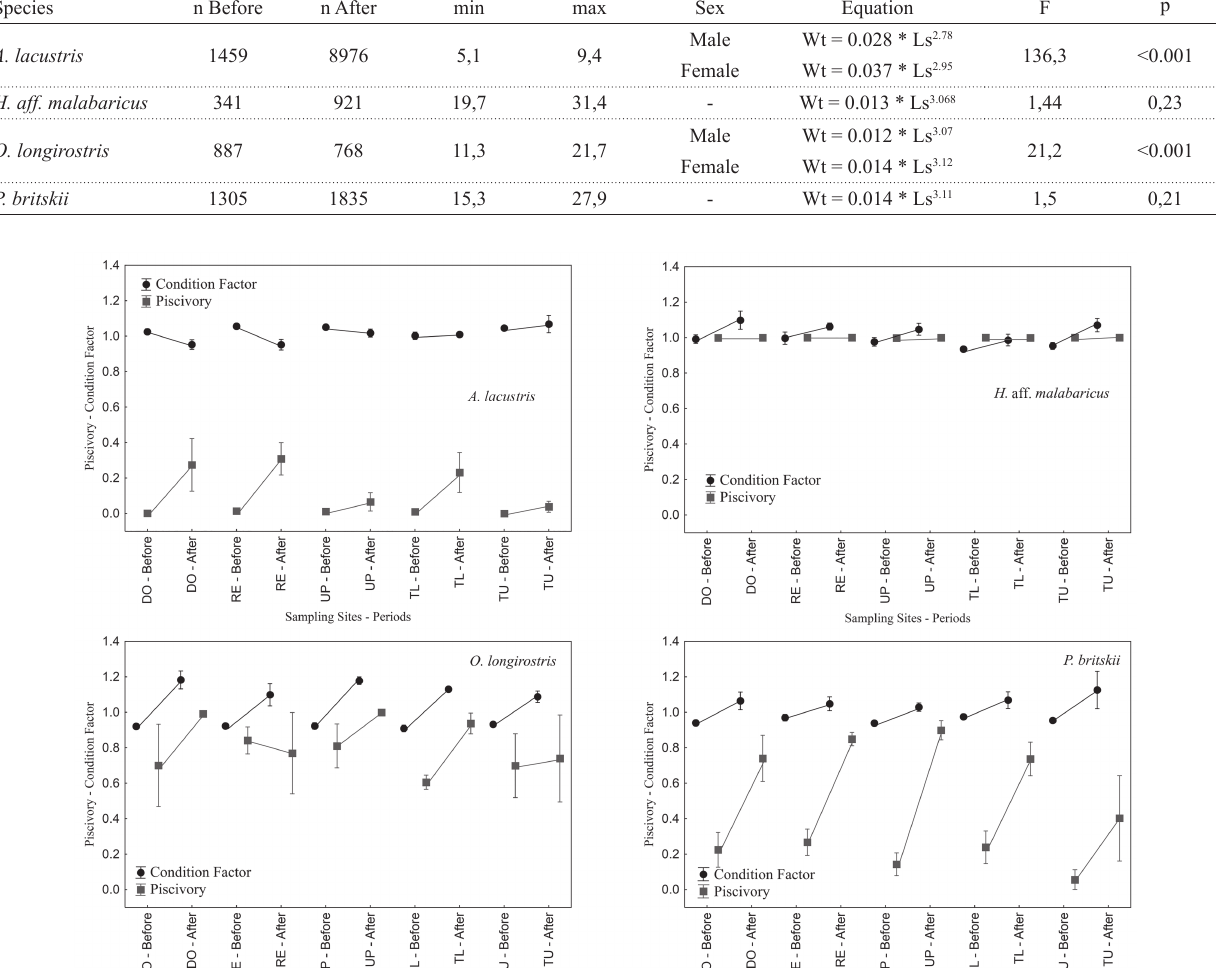
Table 4. Length-weight relationship and covariance analysis results for the analysed species in the Iguaçu River and its tributaries, in the Salto Caxias Reservoir region. n-Number of analyzed individuals for the condition factor and repletion index. Min-Minimum standard length (cm) and Max-Maximum standard length